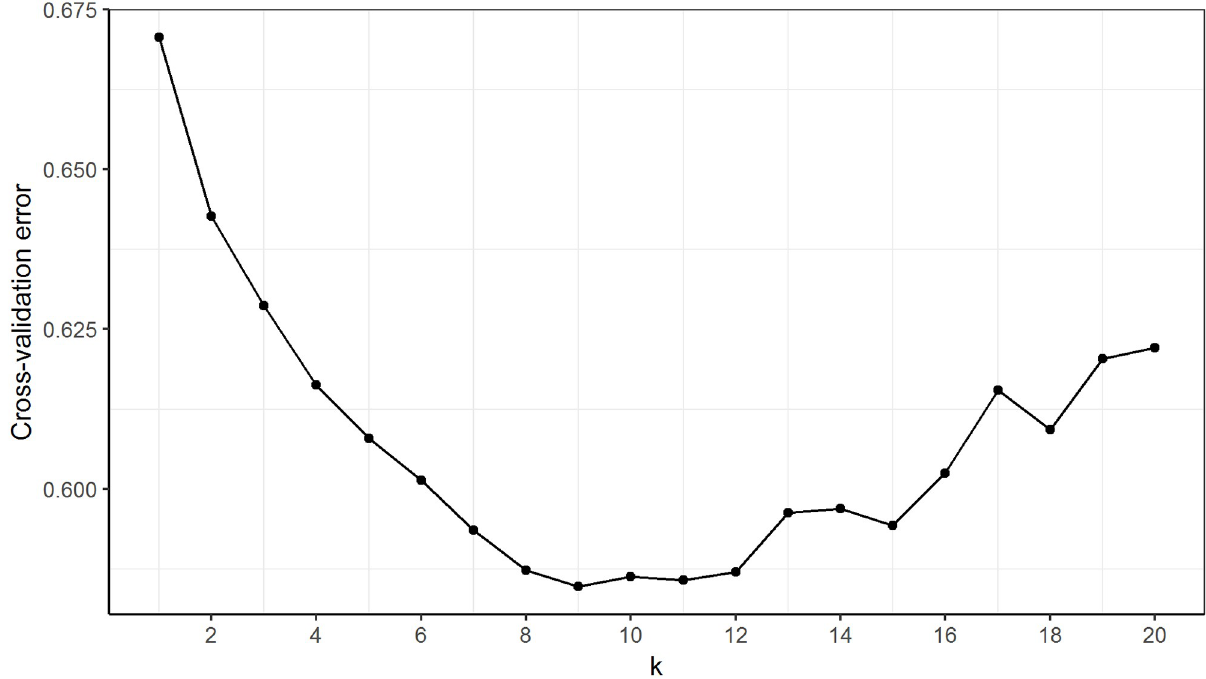
Fig 8. Development of the cross-validation for different number of clusters (k) with k = 9 showing the lowest error